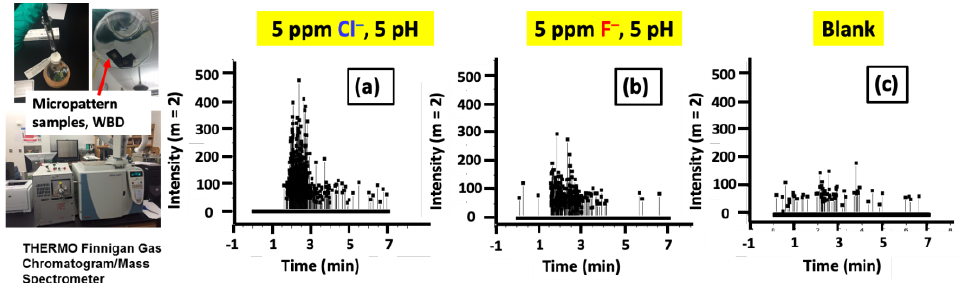
Figure 9. GC – MS analysis of H 2 evolution in microdot samples immersed for 40 h in 5 ppm, pH 5 solutions showing ( a ) intense gas evolution signal in Cl − solution, ( b ) minimal gas evolution signal in F − solution, ( c ) blank signal without any gas evolution.